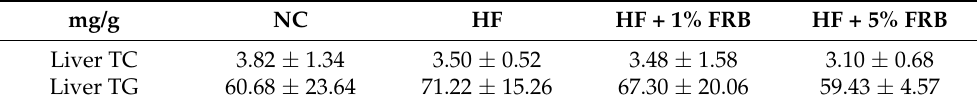
Table 5. Effects of the water extract of fermented rice bran (FRB) on hepatic total cholesterol (TC) and triglyceride (TG) levels in aged rats with high-fat (HF) diet